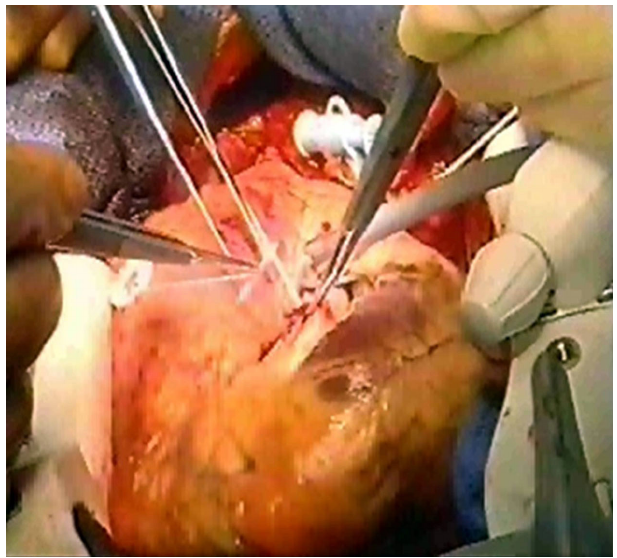
Fig. 1 – Image of the